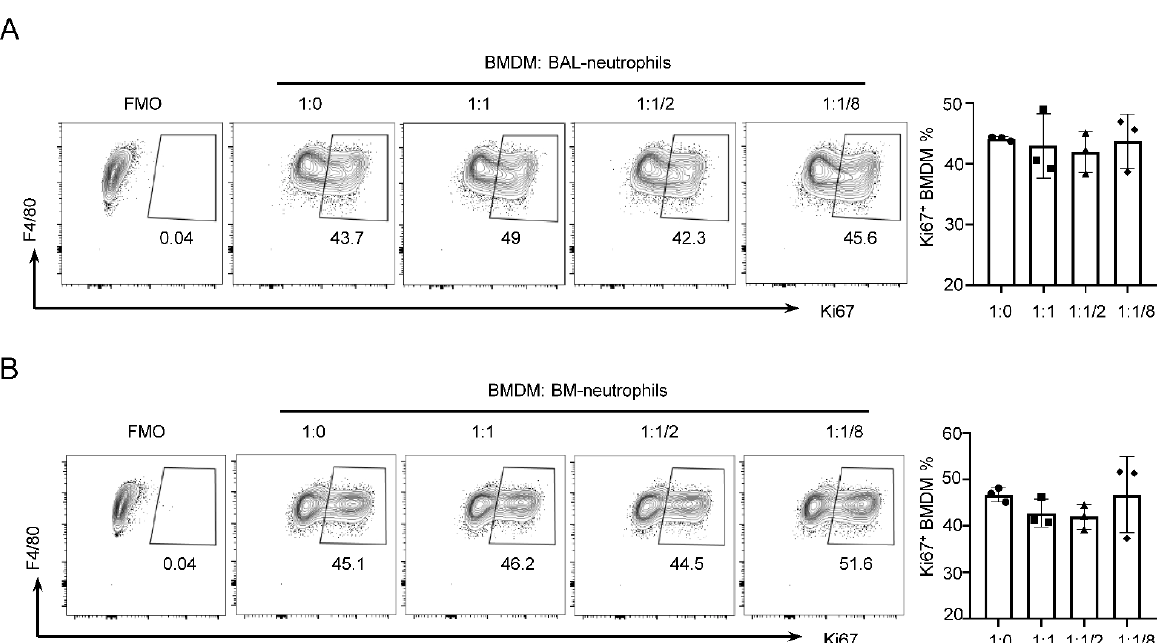
Figure 2. Neutrophils do not affect BMDM proliferation. ( A ) Representative flow cytometry analysis of BMDM proliferation in BMDMs co-cultured with BAL–neutrophils in vitro at a series of ratios. ( B ) Flow cytometry plots and graphs of BMDM proliferation in BMDMs co-cultured with BM–neutrophils in vitro at the same ratios. Data are presented as arithmetic mean ± SD.